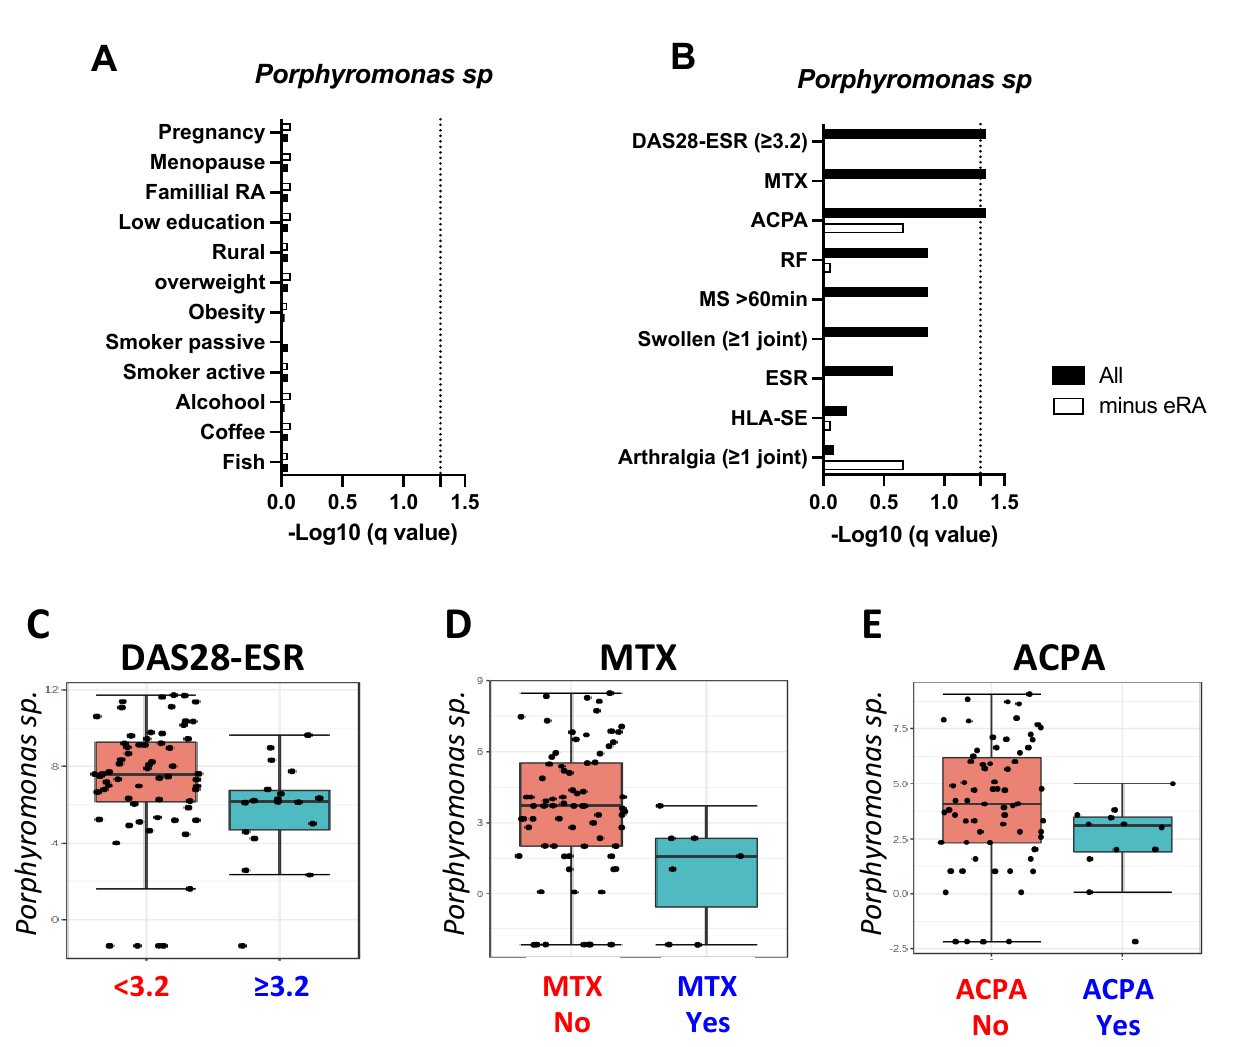
Figure 2. Association between oral Porphyromonas sp. levels and rheumatoid arthritis (RA) associated risk-factors ( A ) and pre-RA/RA clinical factors ( B ) identified by linear discriminant analysis effect size (LEfSe) analysis in 84 individuals including (black boxes) or not (white box, minus eRA) 15 patients with early-(e)RA. For graphical purposes, calculated false discovery rate q values are represented as -Log10 and the significant threshold was fixed at 1.3 (q = 0.05, dot line). Boxplots of the 3 bioclinical factors associated with Porphyromonas sp. level reduction within the 84 individuals: ( C ) disease activity (DAS28-ESR); ( D ) the use of methotrexate (MTX); and ( E ) anti-citrullinated peptide/protein antibodies (ACPA).